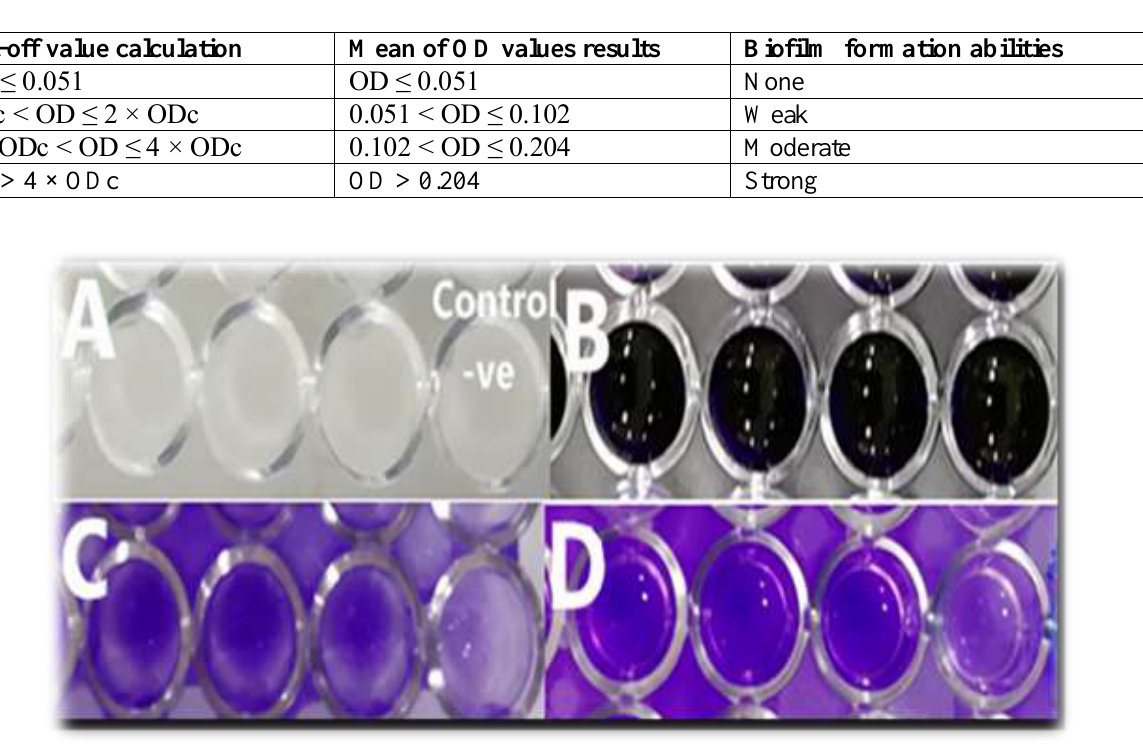
Figure 1: Detection of Biofilm Formation by K.pneumoniae (A) After isolates were incubated for 24 h at 37°C, (B) During staining with 1% crystal violet, (C) Biofilm after staining, (D) After dissolving the adherent cells with 95% ethanol. Negative control contained (TSB with 1 % Glucose)